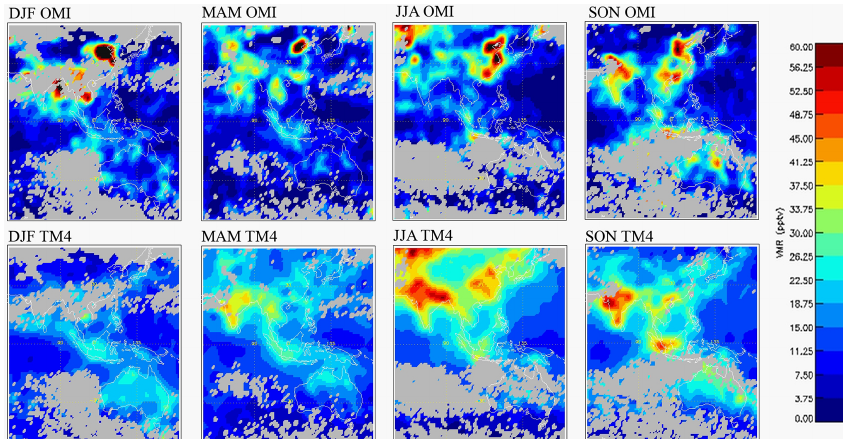
Figure 25. Same as Fig. 24 but at 380hPa.